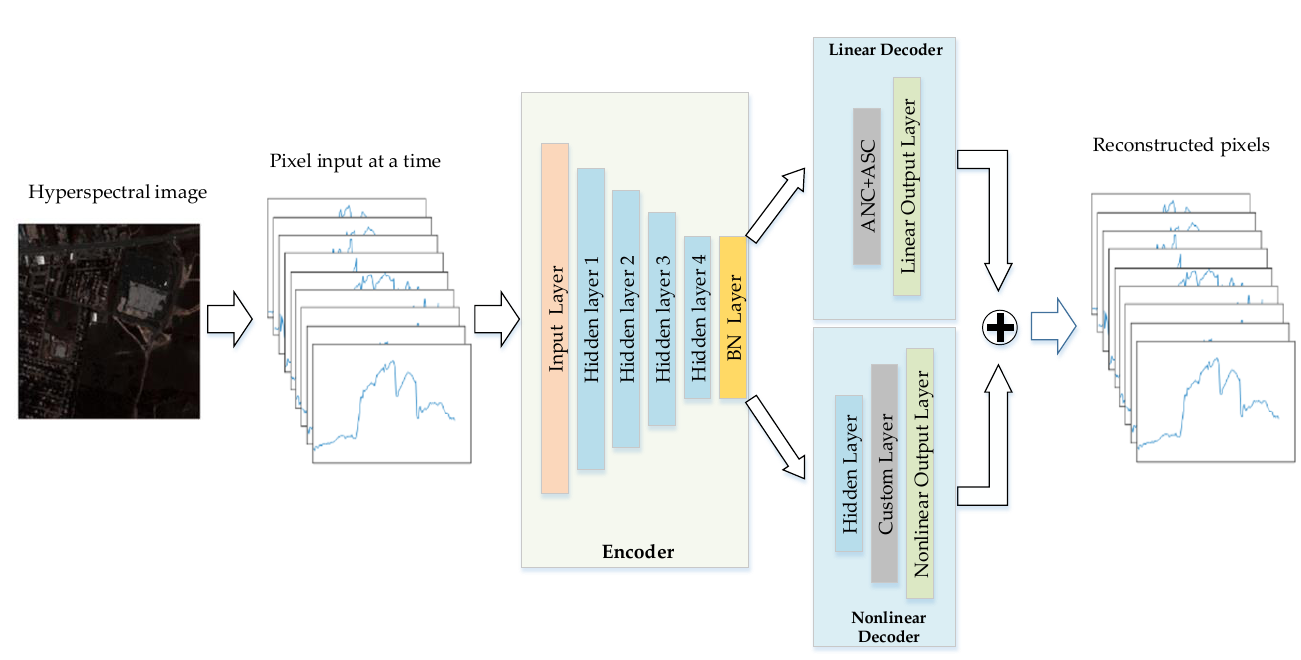
Figure 1. Structure of the Proposed Autoencoder Network based on GBM.